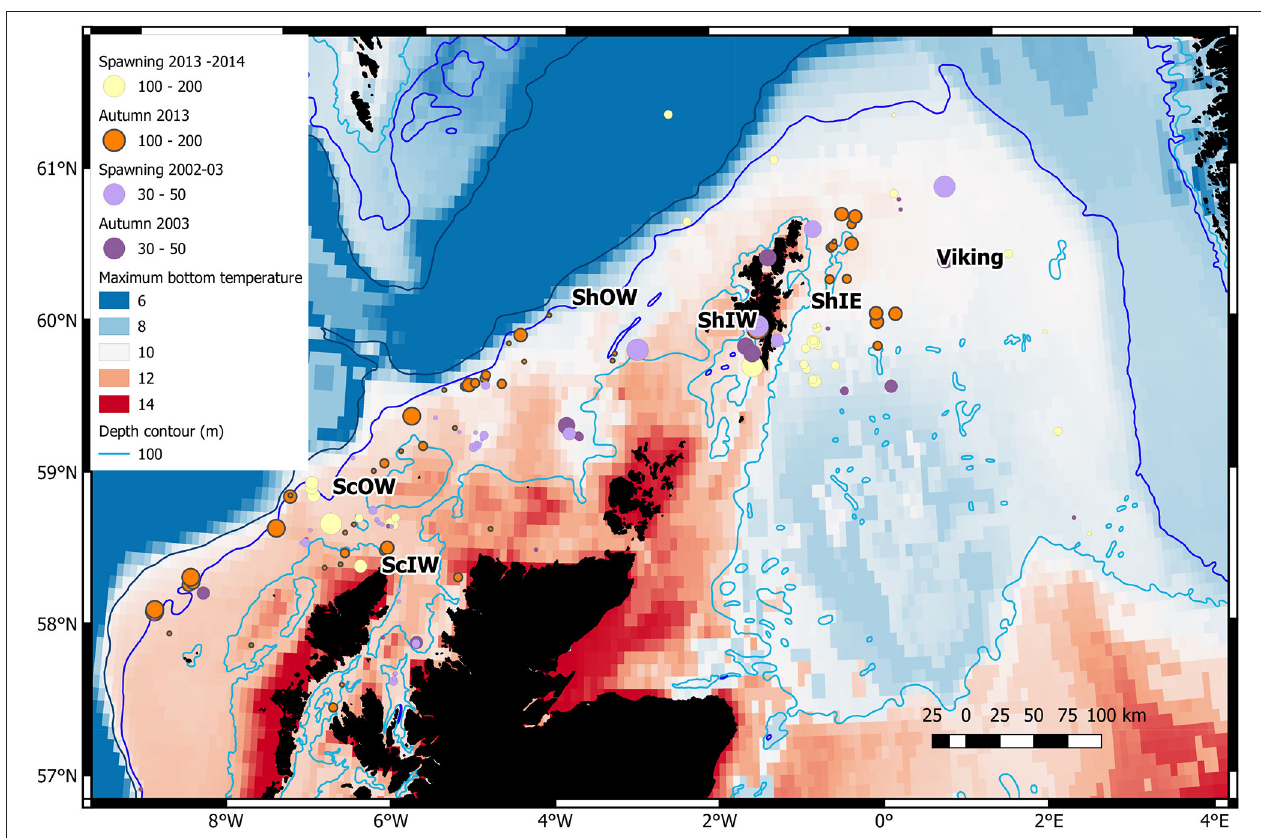
FIGURE 1 | Distribution of genetic samples in relation to maximum seasonal bottom temperature ( ◦ C) for the spawning and autumn seasons in sampled years. The centre of 6 areas identified in Table 1 are indicated. Circle diameters are related to sample size (note larger sample sizes in 2013–14). The 200m depth contour is also